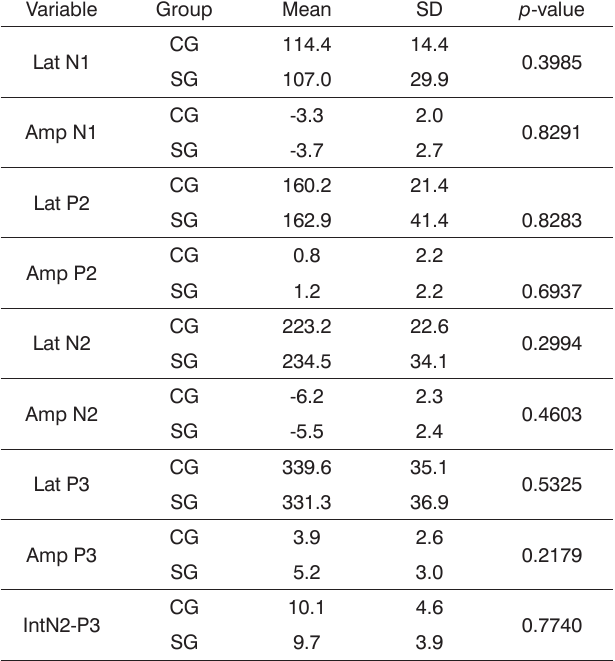
Table 3. Descriptive statistics of the mean, standard deviation (SD) and p -value of the N1, P2, N2 and P3 amplitude and latency variables and P300d N2-P3 inter-amplitude for the RE.